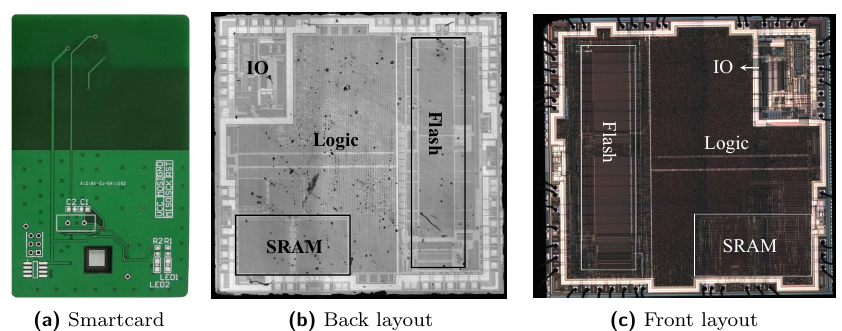
Figure 1: The backside of decapsulated µ C with its